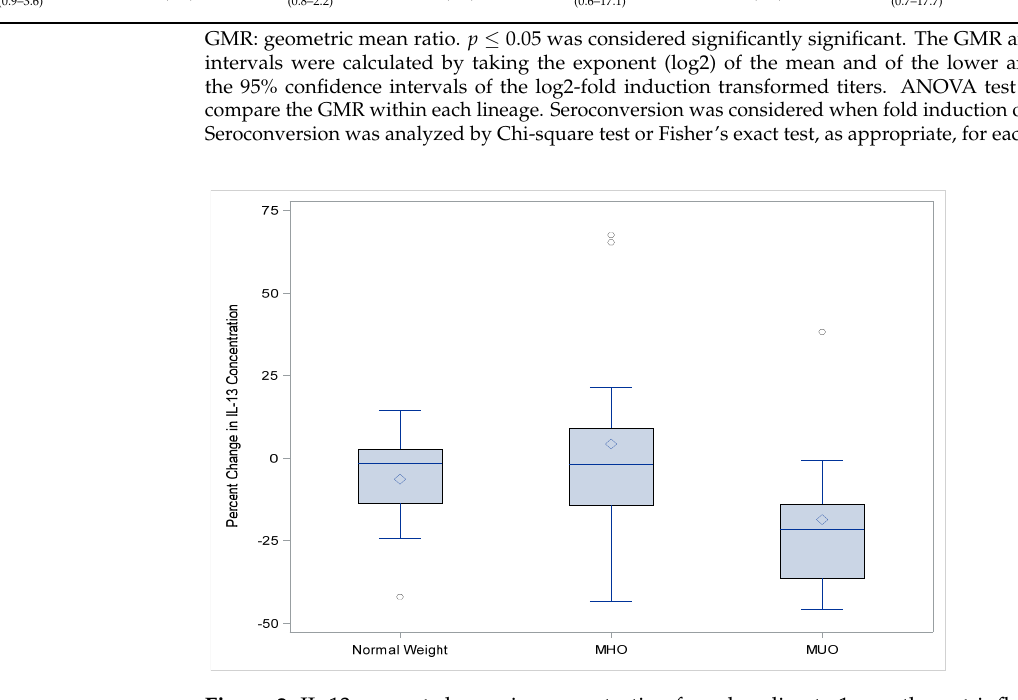
Figure 2. IL-13 percent change in concentration from baseline to 1-month post-influenza vaccination ( p < 0.04).